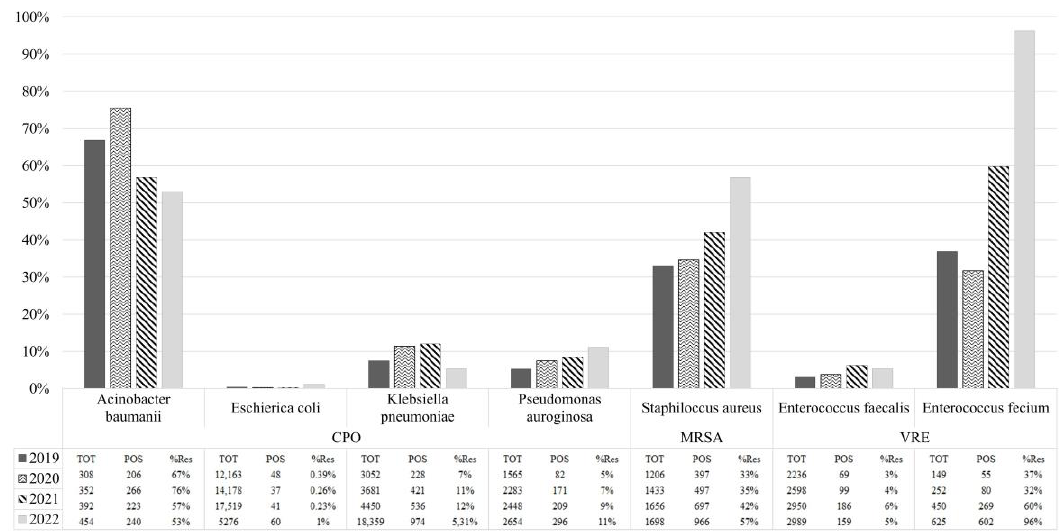
Figure 2. AMRs trend during the study period divided by bacterial species.